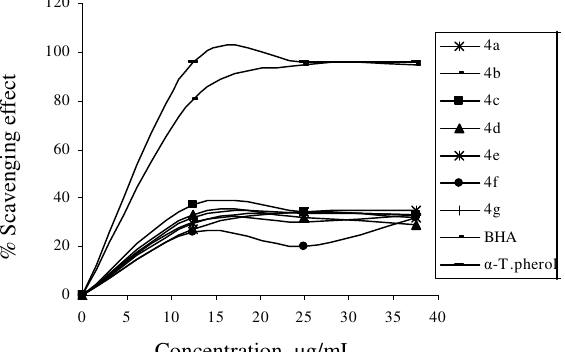
Figure 1. Scavenging effect of compounds 4a-g , BHA and α -tocopherol at different concentrations (12.5-25-37.5 µg/mL).